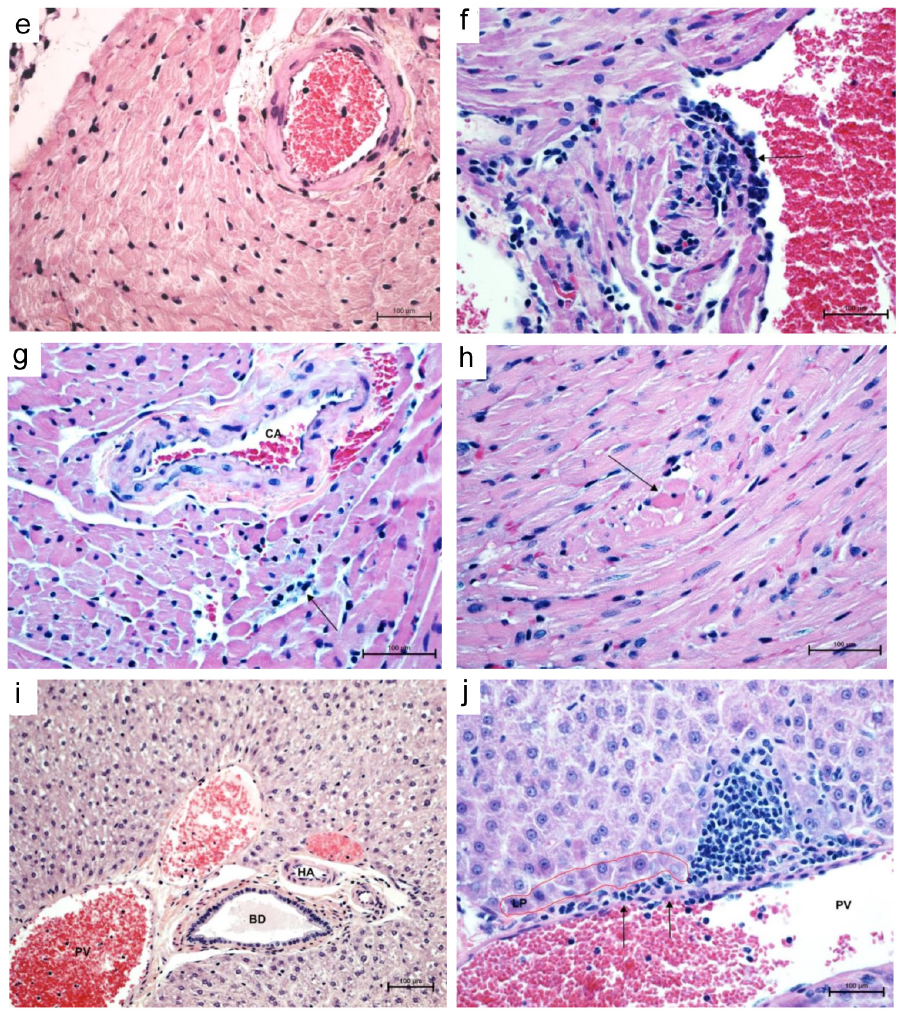
Figure 2. Histopathology of cardiopulmonary phase of MAPV infection in deer mice. Control lung (day 14) shows clear airways (bronchiole, B) and air spaces, normal vessels (pulmonary artery, PA) and normal thickness of interstitium ( a , 200 × ). Lungs 14 days PI show alveolar hemorrhage, edema, and mild interstitial pneumonia ( b , 100 × ). Lungs at 14 days PI show prominent perivascular (portal vein, PV, and artery, PA) neutrophilic infiltrates with mild interstitial pneumonia ( c , 400 × ; d , 200 × ). Control heart shows a normal coronary artery and surrounding myocardium ( e , 200 × ). Left atrium 7 days PI shows endothelial hypertrophy and hyperplasia with lymphocyte infiltration into subjacent myocardium with sarcoplasmic hyalinization and vacuolation of sarcoplasm with loss of cross striations ( f , 400 × ). At 56 days PI, coronary artery (CA) with hypertrophic endothelium and perivascular edema, interstitial lymphocytic myocarditis and cardimyocyte degeneration/necrosis ( g , 400 × ) and necrotic cardiomyocytes appear rounded up with hyperesinophilic sarcoplasm and pyknotic nuclei ( h , 400 × ). Control liver shows intact limiting plate around normal portal vessels, hepatic artery (HA) and bile ductile (BD) ( i , 200 × ). Focal disruption of portal vein (PV) endothelium (arrows) with lymphocytes percolating the limiting plate (LP) into the surrounding parenchyma mixed with a few neutrophils ( j , 400 × ). Stain,